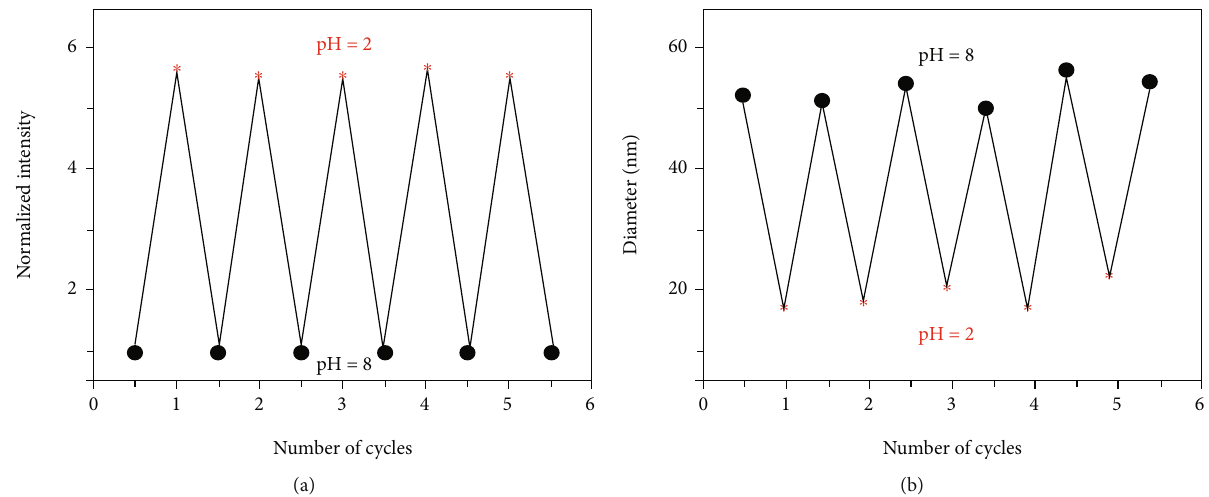
Figure 6: Evolutions of (a) normalized fl uorescence intensity and (b) hydrodynamic diameters when pH was cycled between 2 and 8 + ]/[COO - ] molar ratio was ( λ ex = 345 nm, 25 ° C). The [NH 3